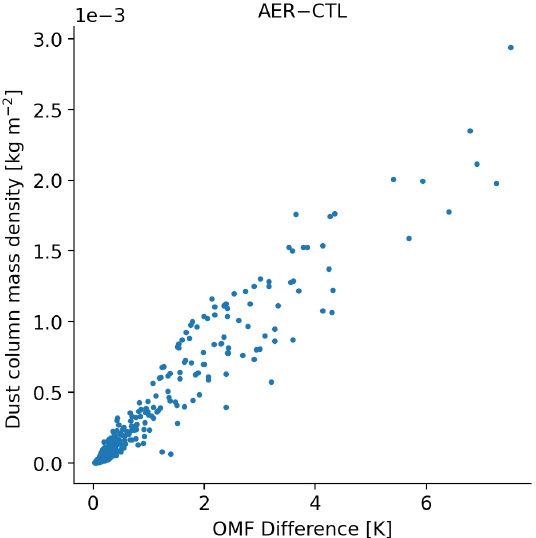
Figure 4. The scatter plot of dust column mass density from MERRA-2 against the first-guess departure differences (AER − CTL) assimilated in AER experiment (without bias